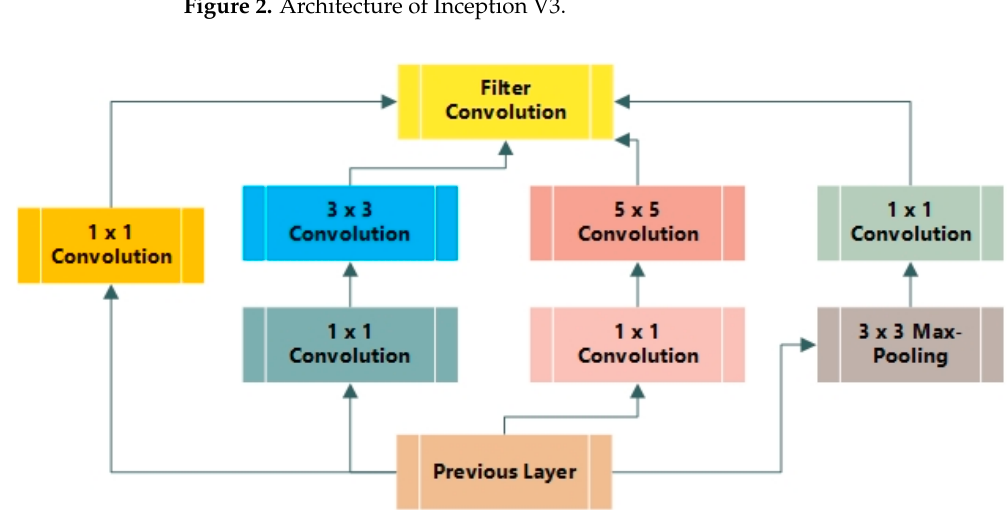
Figure 3. Structure of basic Inception model .